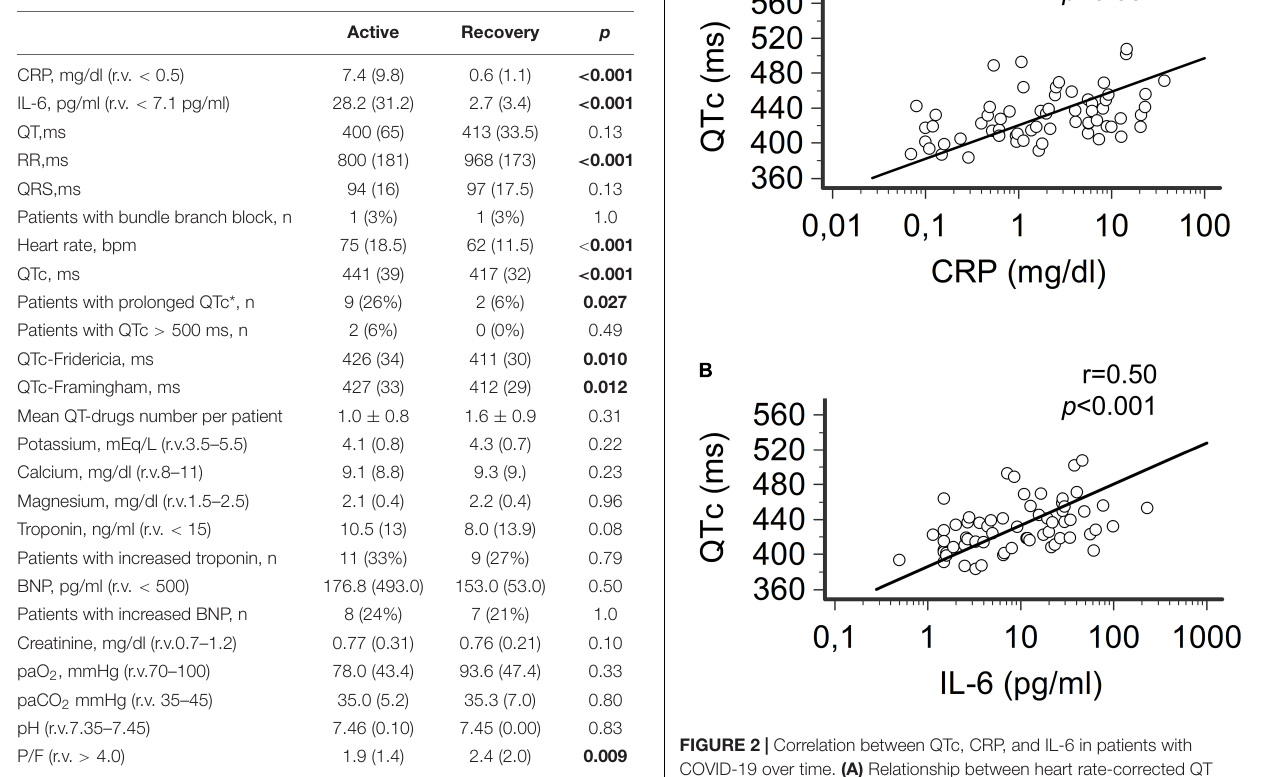
TABLE 2 | Changes in laboratory and electrocardiographic parameters in patients with COVID-19 ( n = 33), during active disease and after therapeutic interventions resulting in a > 60% decrease in IL-6 level when compared to the baseline.